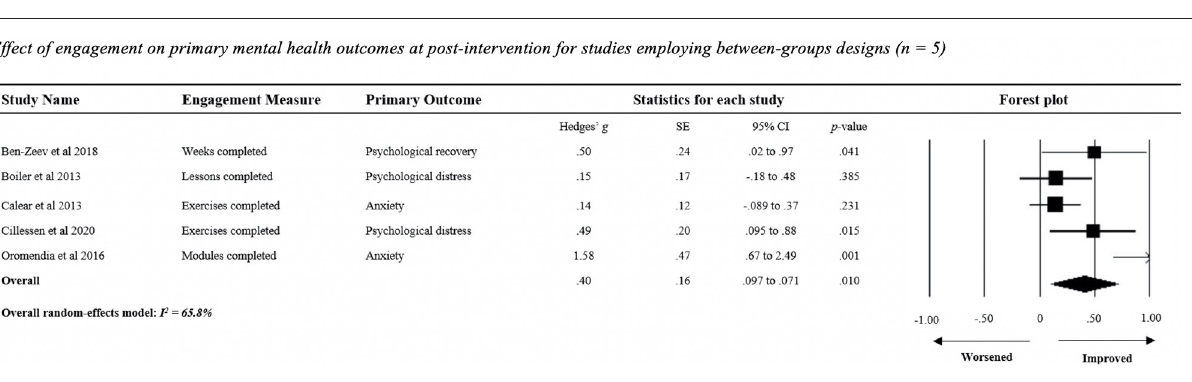
FIGURE 3 | Effect of engagement on primary mental health outcomes at post-intervention for studies employing between-groups designs ( n =